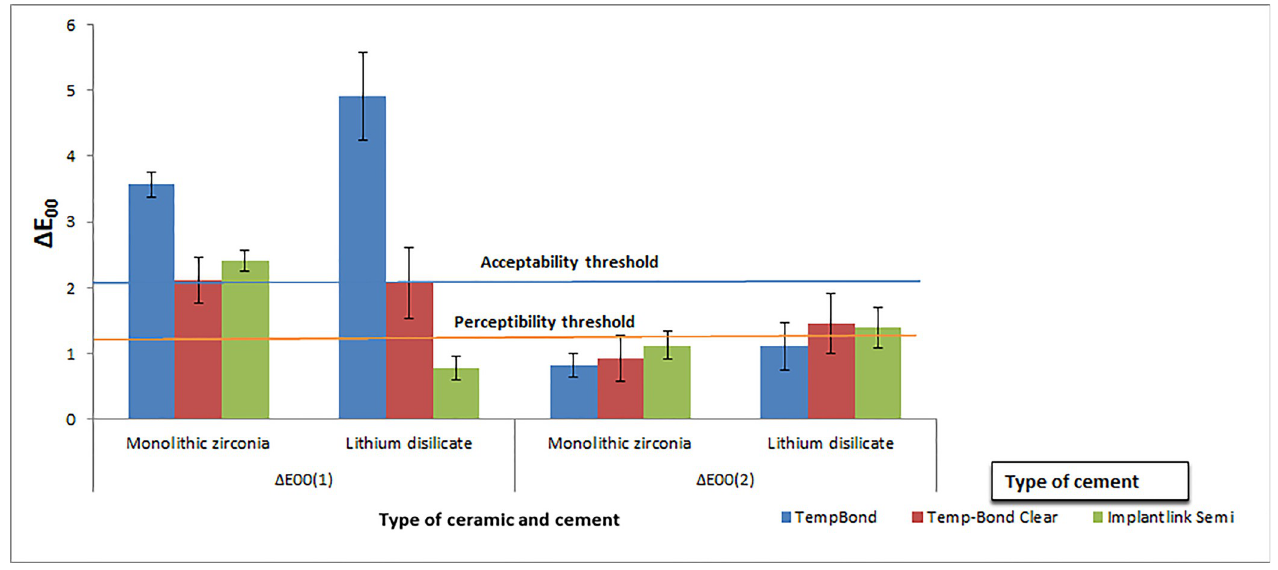
Fig 3. Mean and standard deviation of Δ E 00 (1) and Δ E 00